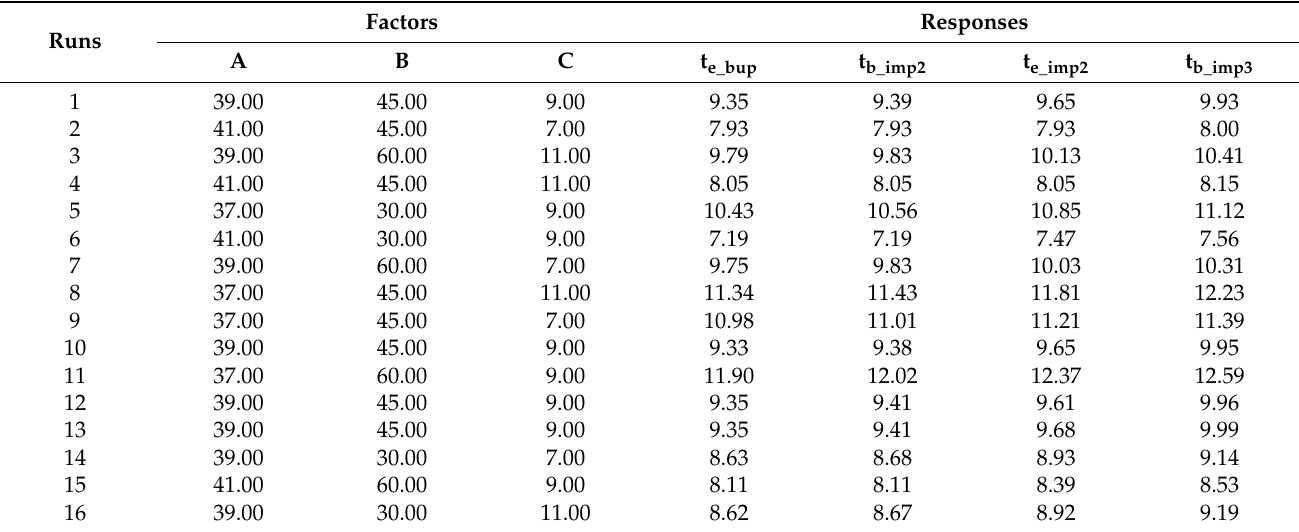
Table 2. Plan of experiments proposed from software for BBD and the obtained responses.